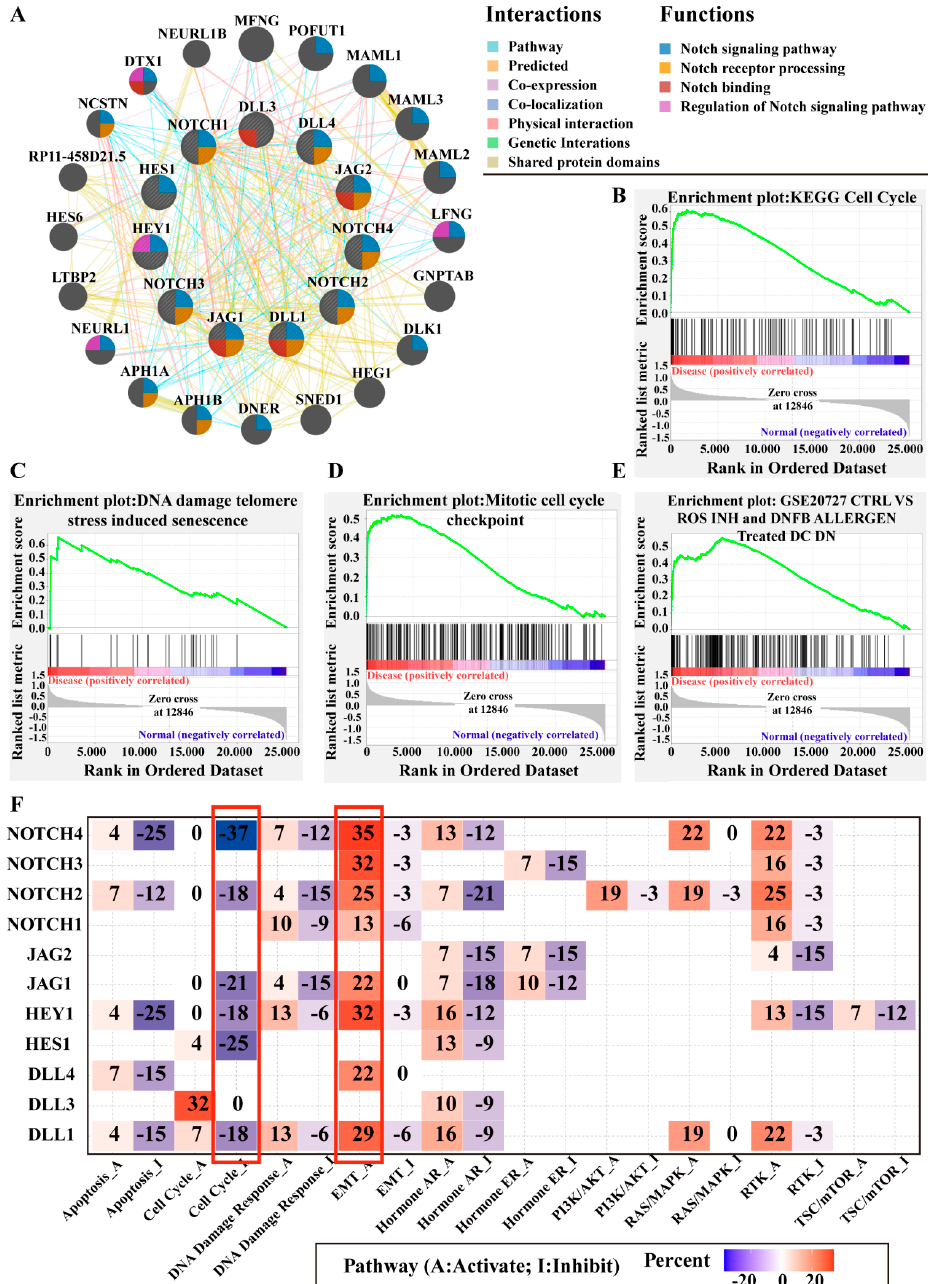
Figure 8. Interaction network of frequently interacting genes and the canonical pathway analysis using GSEA. ( A ) Gene to gene interaction network with frequently interacting genes (GeneMANIA, accessed on Nov.12. 2020): (i) the node size represents the strength of interaction; (ii) color of lines represents the types of interaction between genes (color code in Interactions legend); (iii) colored node circle sections represent the functions of respective genes (color code in Functions legend). ( B ) The most significant canonical pathways in terms of the KEGG database. ( C ) The most significant canonical pathways in terms of Reactome pathway database. ( D ) The most significant biological process according to Gene Ontology. ( E ) The most significant immunologic signature gene sets; NES = normalized enrichment score. ( F ) The relationship between Notch factors with well-known cancer-related signaling pathways; _A (activating); _I (inhibiting); values indicate the percentage of BCa cases in the associated pathway; positive values (activating, red), negative values (inactivating, blue); empty values = no significant correlation was detected; red frame indicates the two most relevant pathways. For full gene names and description of “GSE20727 CTRL vs. ROS INH and DNFB allergen-treated DC DN”, please see list of abbreviations (File